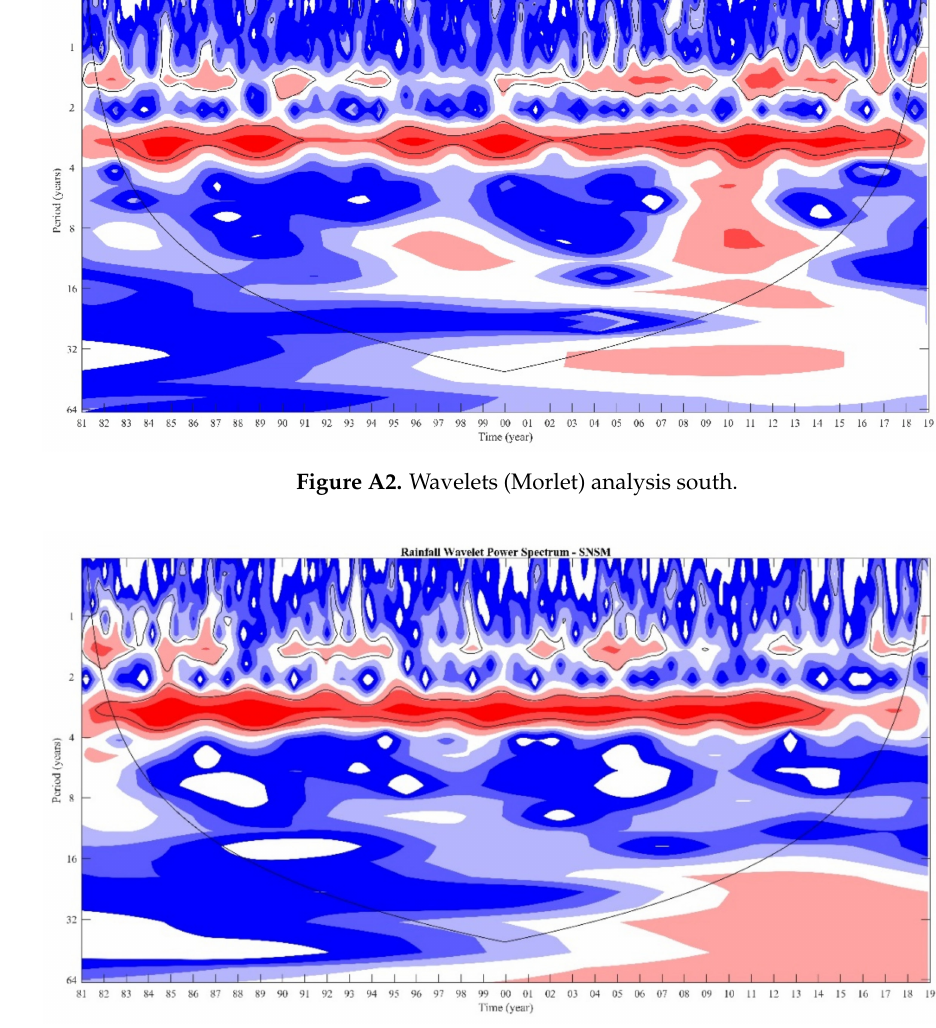
Figure A3. Wavelets (Morlet) analysis